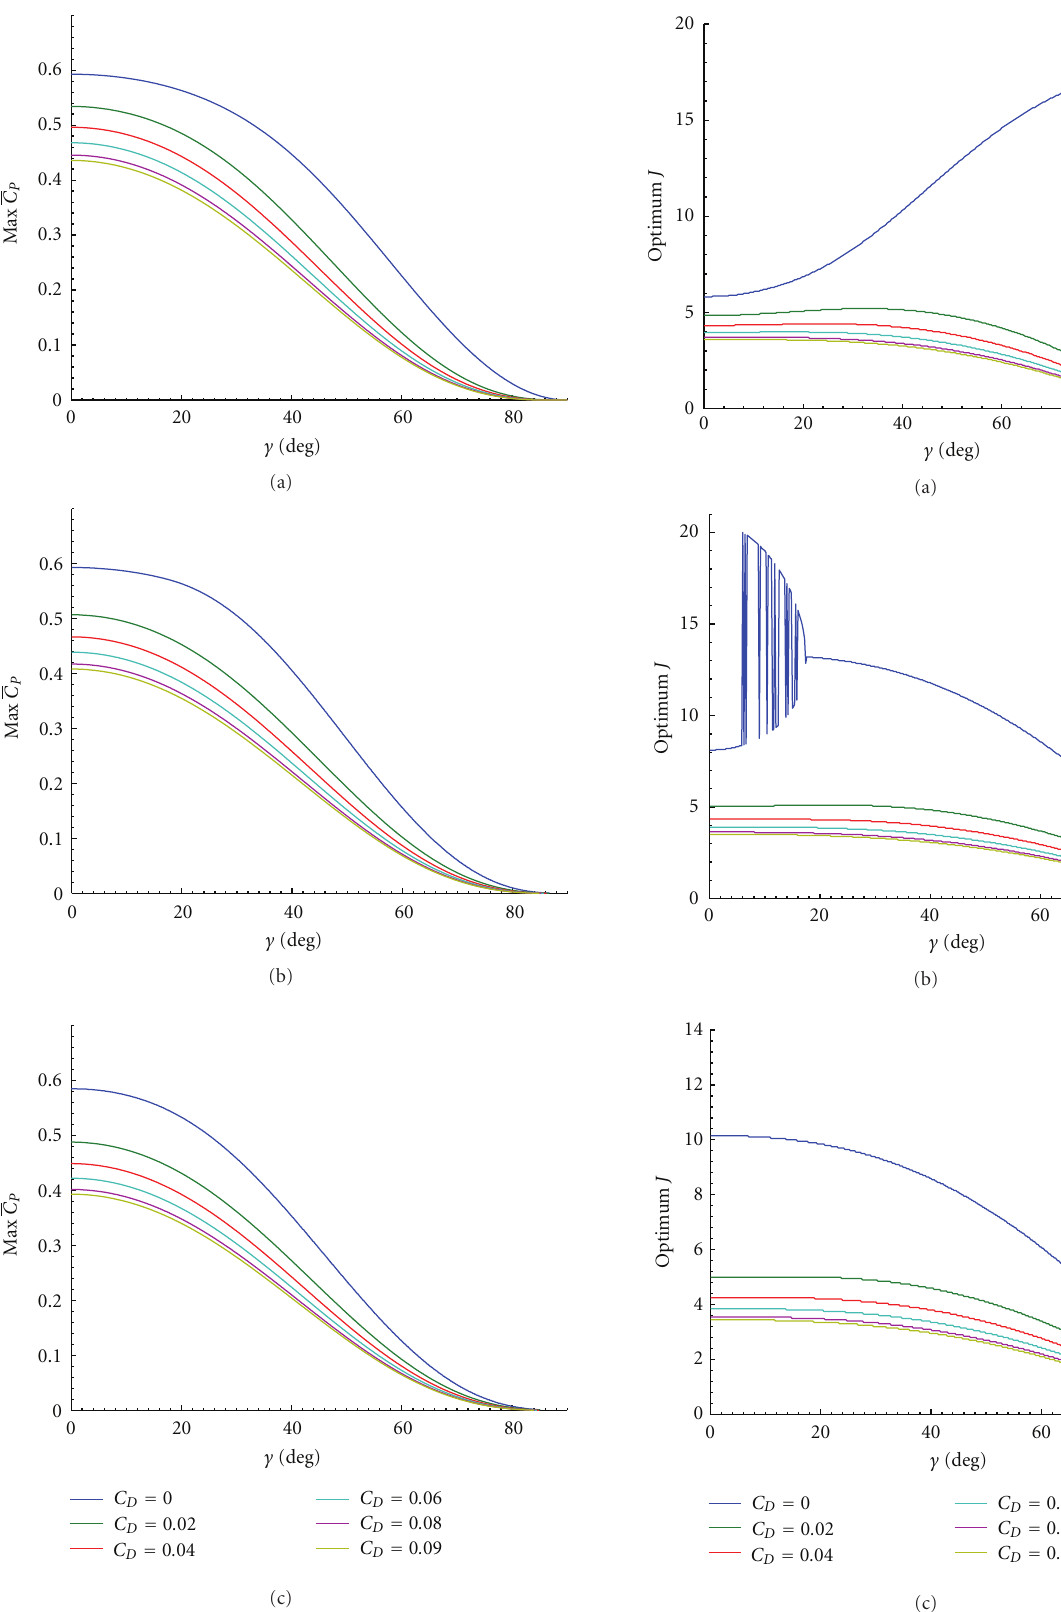
Figure 21: (a) Optimum J versus γ for θ = 0 ◦ , (b) Optimum J versus γ for θ = 2 ◦ , and (c) Optimum J versus γ for θ = 3 ◦